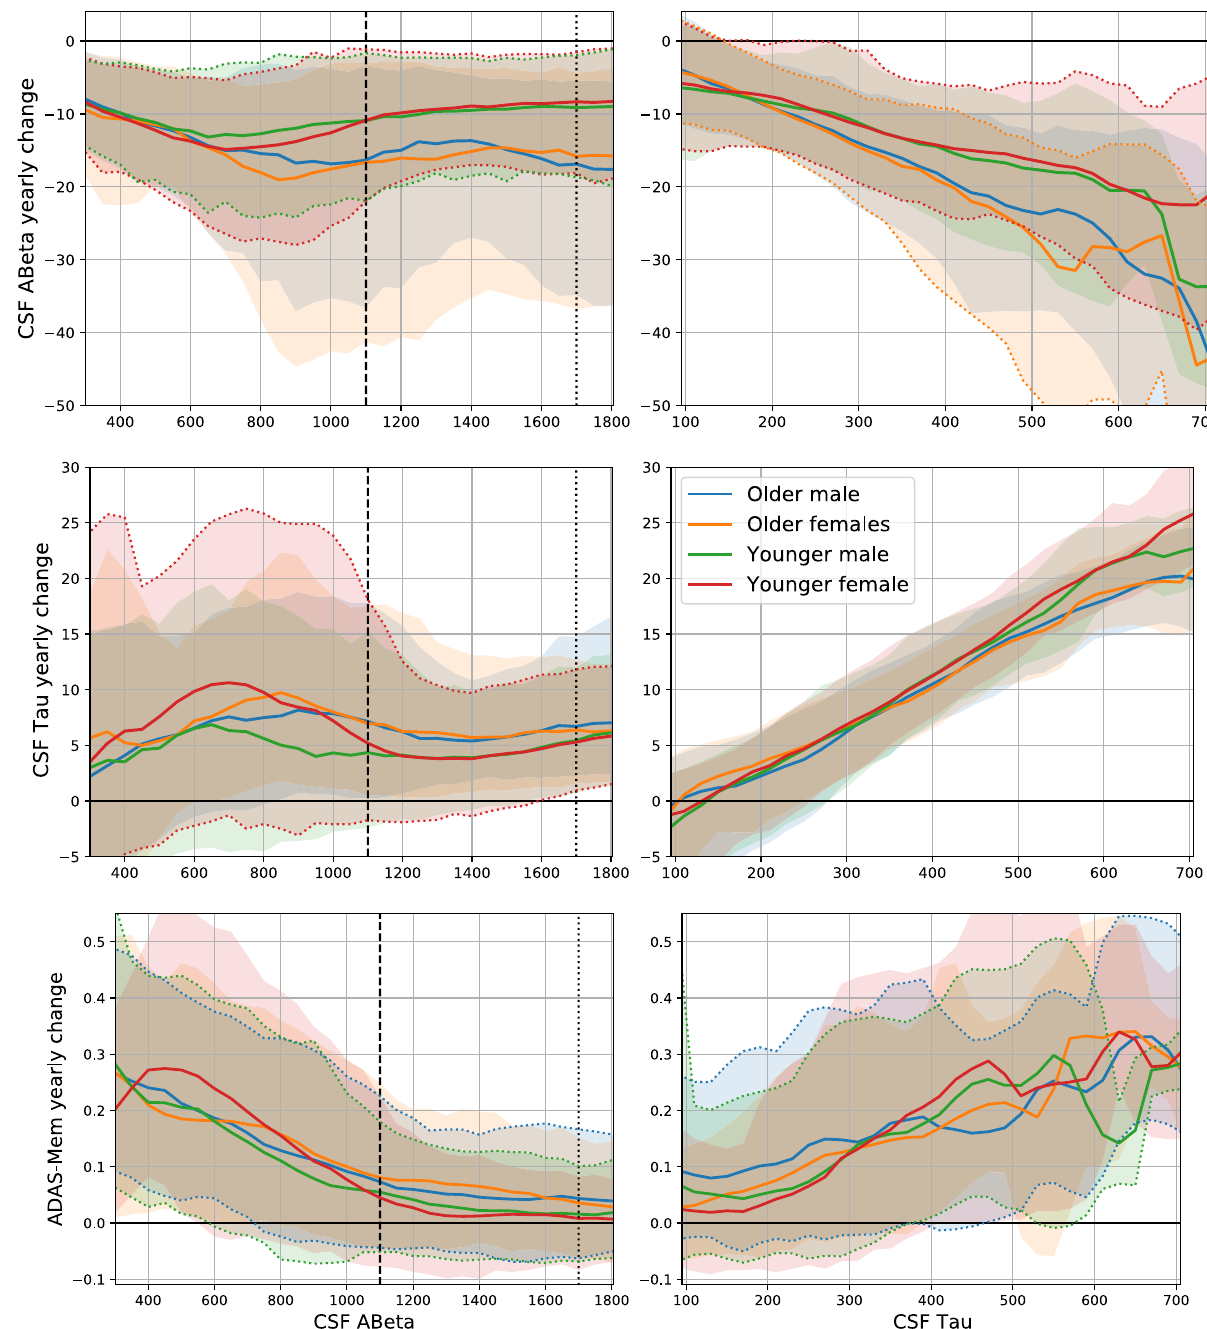
Figure 3. Biomarker (Top and middle) and cognition (Bottom) rates of change for different biomarker basal levels (CSF A β on the left and CSF Tau on the right). Shaded regions show the expected velocity distribution (90% HDI posterior probability) for the ADNI population conditioned on CSF A β or CSF